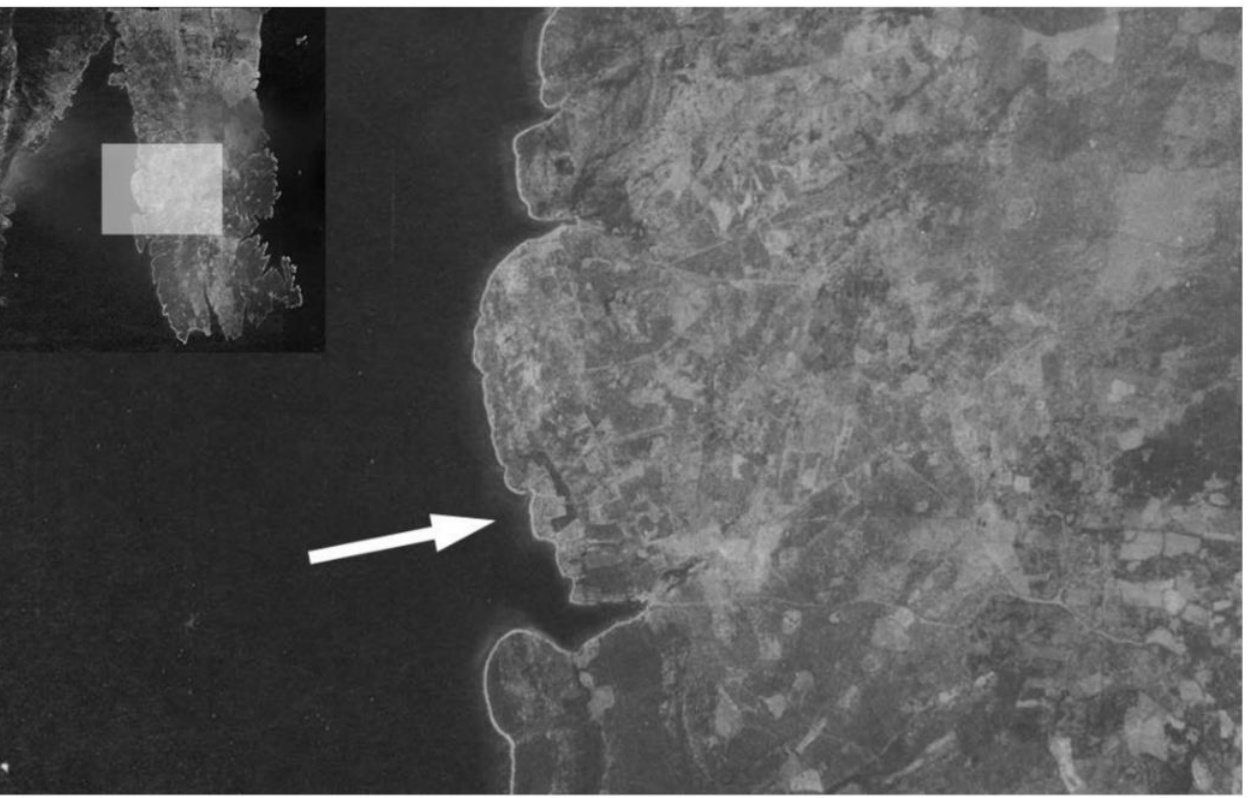
Figure 8. Second World War reconnaissance photograph taken on 28 April 1944 covering the southern part of the island of Cres between Osor ( top ) and Punta Križa ( bottom of overview image). The arrow identifies the case study area. Copyright: NCAP/ncap.org.uk. (Frame number 5039, sortie 60PR/0366, 28 April